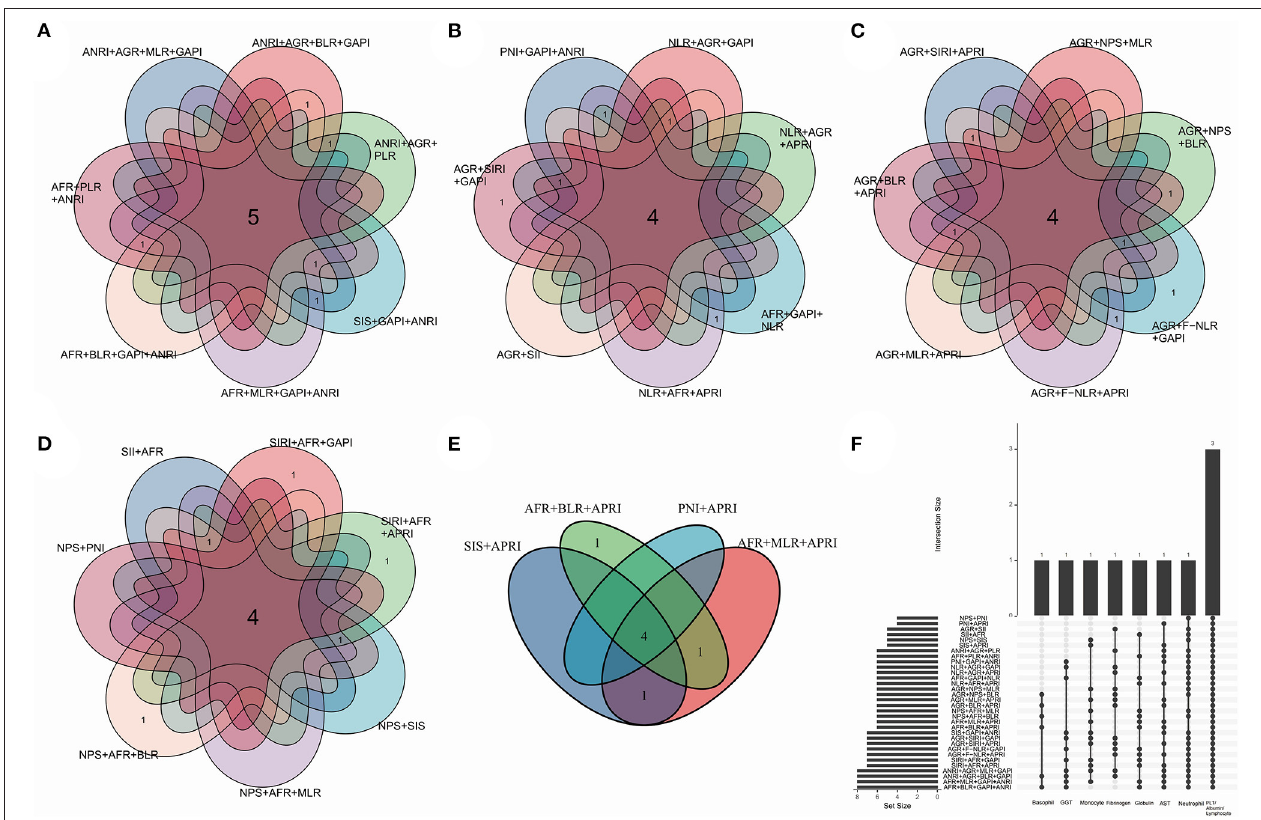
FIGURE 3 | Venn plots indicating a total of thirty-two combinations of thirteen biomarkers. Demonstration in separate (A–E) and total (F) manners. Each combination contained fixed variables including gender, age, primary site, grade, stage, scope of surgery, smoking index, adjuvant therapy, surgical method (video-assisted thoracoscopic surgery or not), together with the alternative biomarkers which contains unique blood cell/serum indices. The biomarkers were significant ( p < 0.100) in univariate Cox analysis. The numbers in the overlapping region showed the common blood cell/serum indices between two